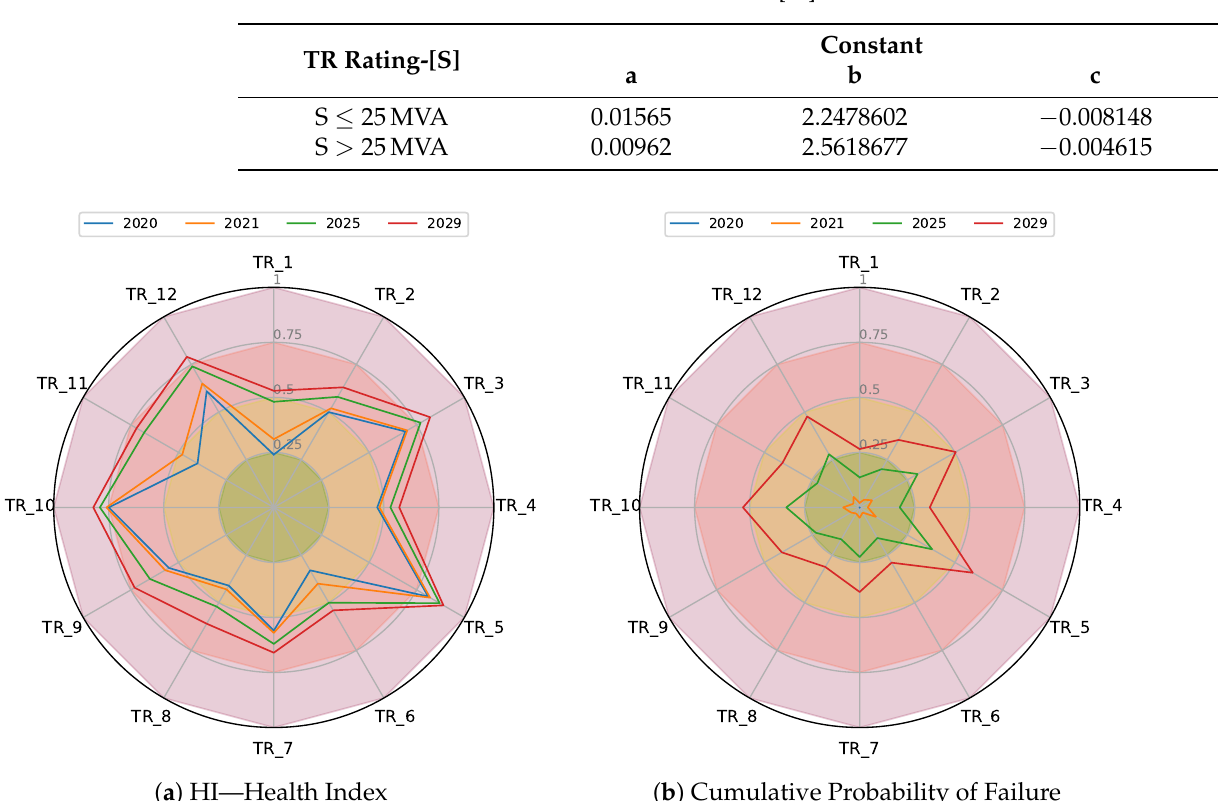
Table 3. Constants to estimate transformer failure rate [20].